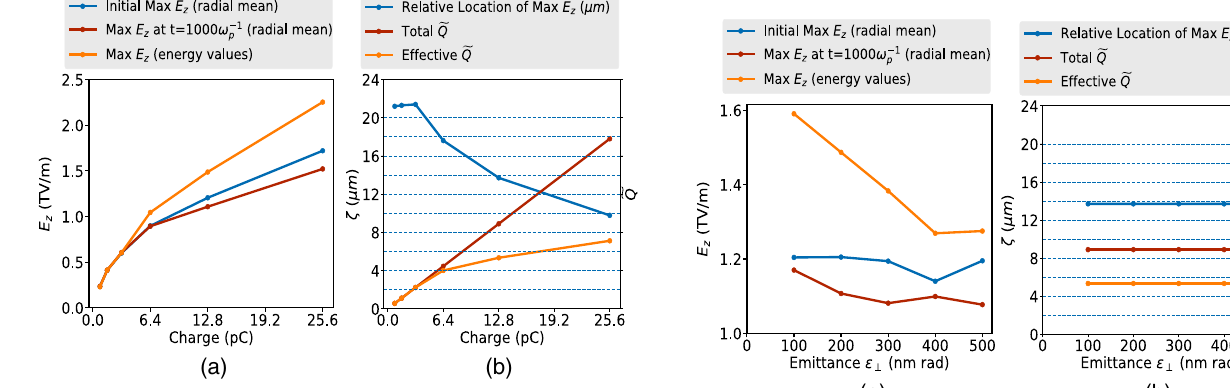
FIG. 5. (a) The variation of initial, final and average maximum axial longitudinal electric fields with emittance. The beam is completely bunched and beam charge is kept constant at 12.8 pC. ˜ Q are (b) The location of the peak longitudinal electric field, total and ˜ Q effective normalized charge density are plotted. The dashed lines correspond to the position of the